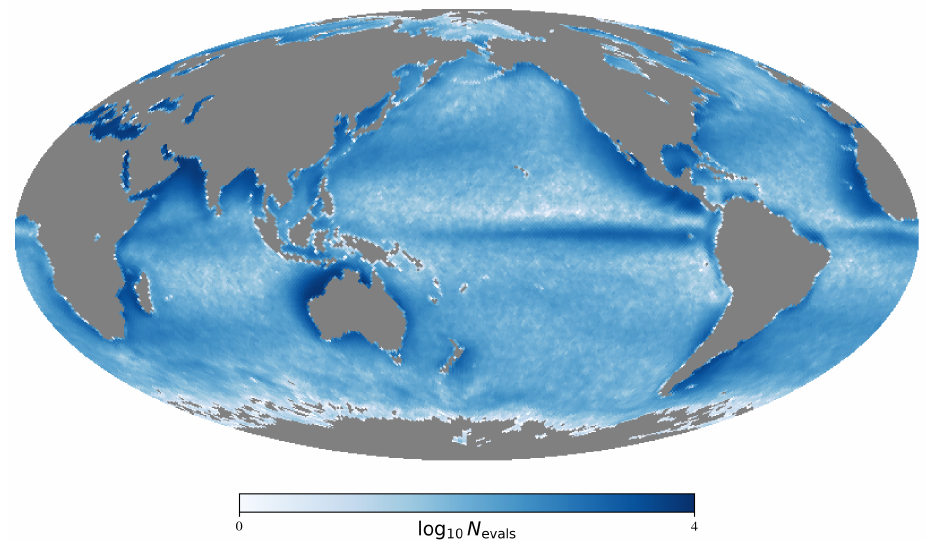
Figure 1. Mollweide projection depicting the log 10 of the spatial distribution of all cutouts analyzed in this manuscript. Note the higher incidence of data closer to land driven by the lower cloud cover (CC) in those